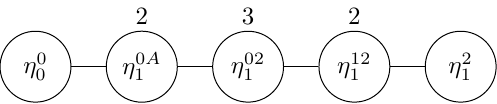
\ T , Resolution I. This (cid:12)ber is of 2 -model at S